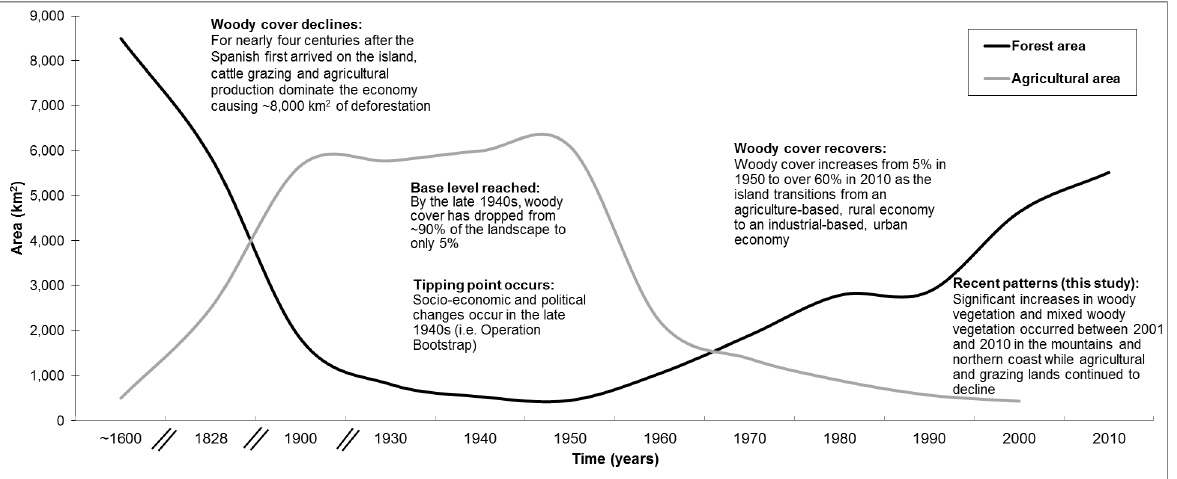
Figure 3. Change in woody and agricultural area (in km 2 ) in Puerto Rico from ~1600 to 2010. Data used to construct this figure was obtained from